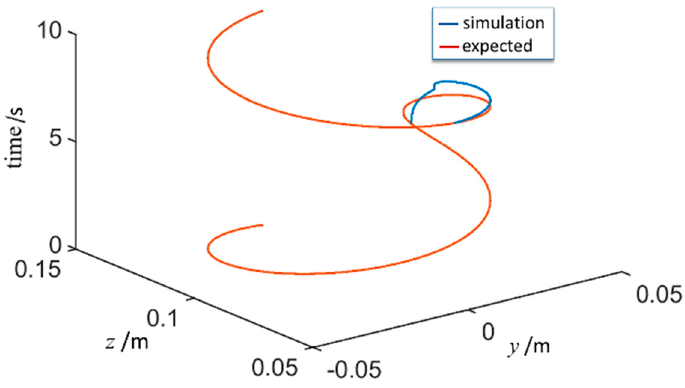
Figure 19. Trajectory of the end of the slave manipulator.